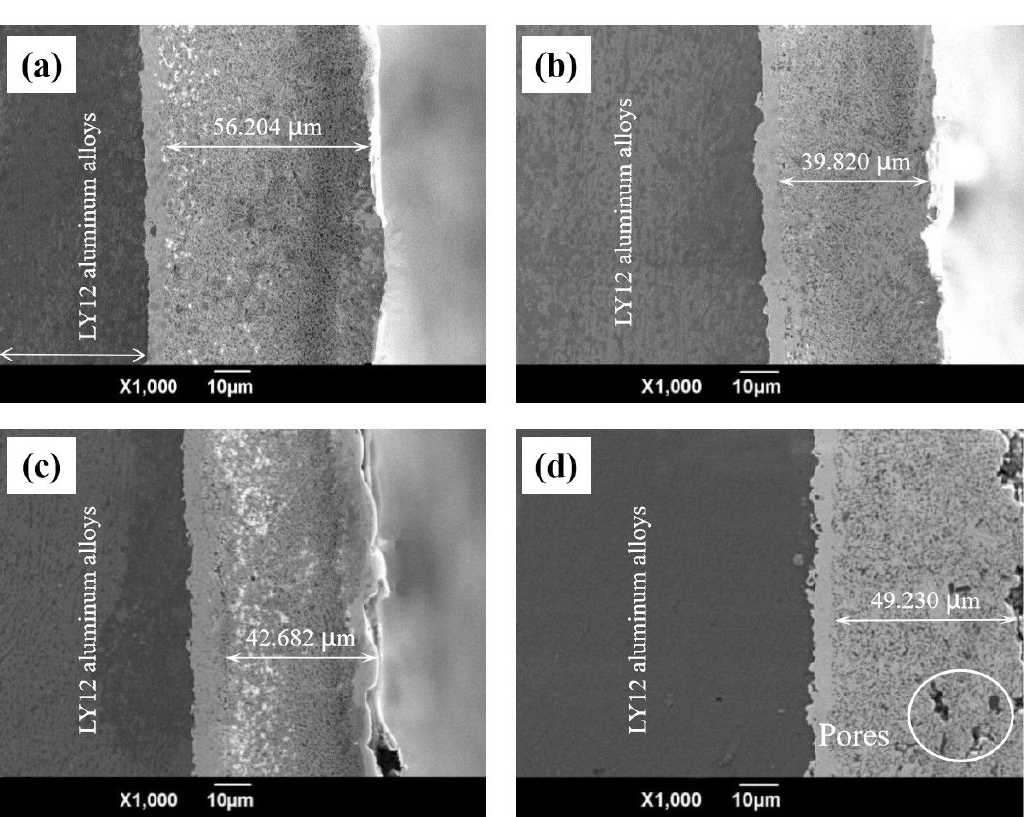
concentrations: (a) 0.5 g·L -1 ; (b) 1.0 g·L -1 ; (c) 1.5 g·L -1 ; (d) 2.0 g·L -1 2